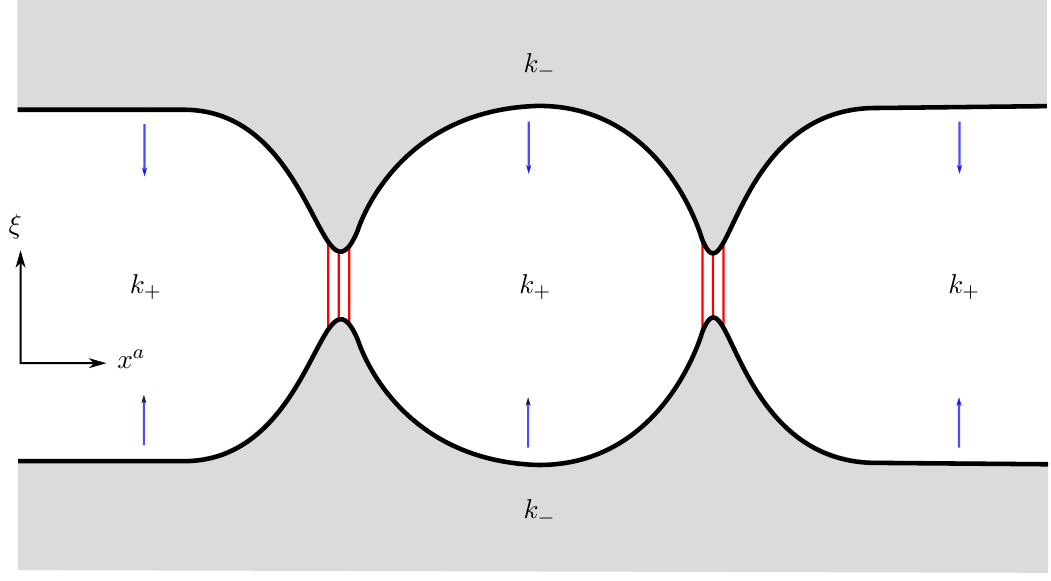
Figure 2 . A cartoon representing strings (in red) stretching between two copies of the world brane (in black) that can be close together. The energy density of the strings and their endpoints on the branes causes them to bend. As the four dimensional universe within the brane expands, the branes move closer to each other (shown with blue arrows). The gravitational perturbation from the strings is localized to the branes and the false vacuum in between. The perturbations decays away as we move out from the sandwich universe into the true